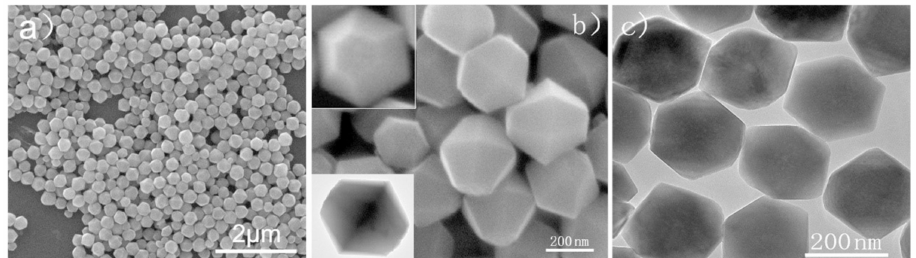
morphology. When the used K 4 Fe(CN) 6 · 3H 2 O is 0.2 mmol, the oblique parallelepiped iron oxide was obtained.